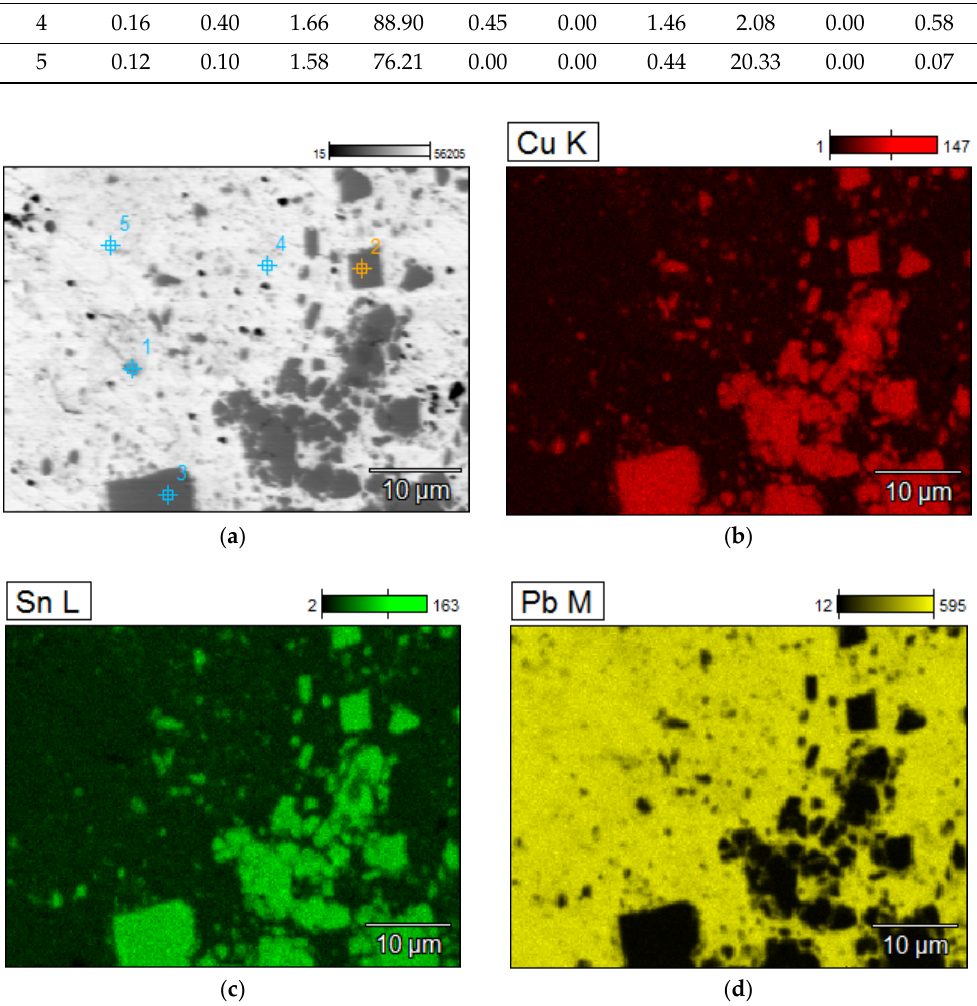
Figure 10. Elements mapping of the lead ingots after melting with PCB pyrolyzate “new”, m PBC / m Pb = 0.1 g ∙ g − 1 . ( a ) scanning electron microscopy with a points of chemical composition; ( b – d ) copper, tin and lead located in specific areas within the alloy. Table 12. Point chemical compositions of the lead ingots after melting with PCB pyrolyzate “new”,